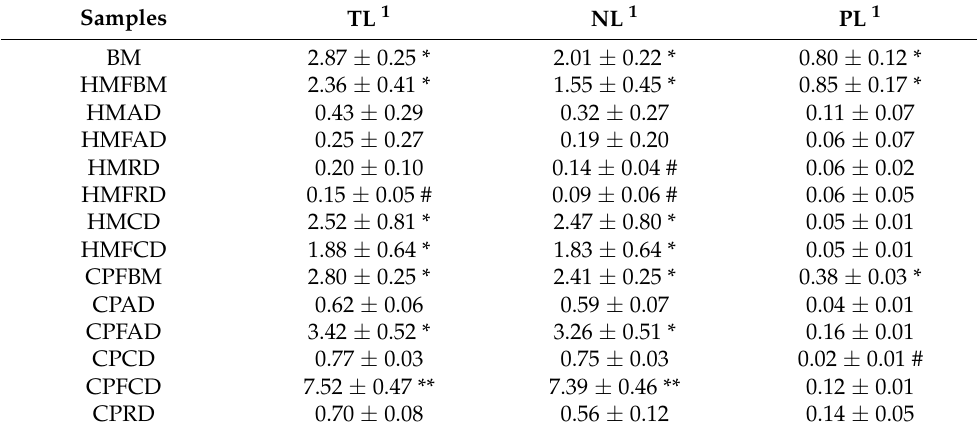
Table 1. Lipid extraction yield for homemade plant drinks and fermented plant